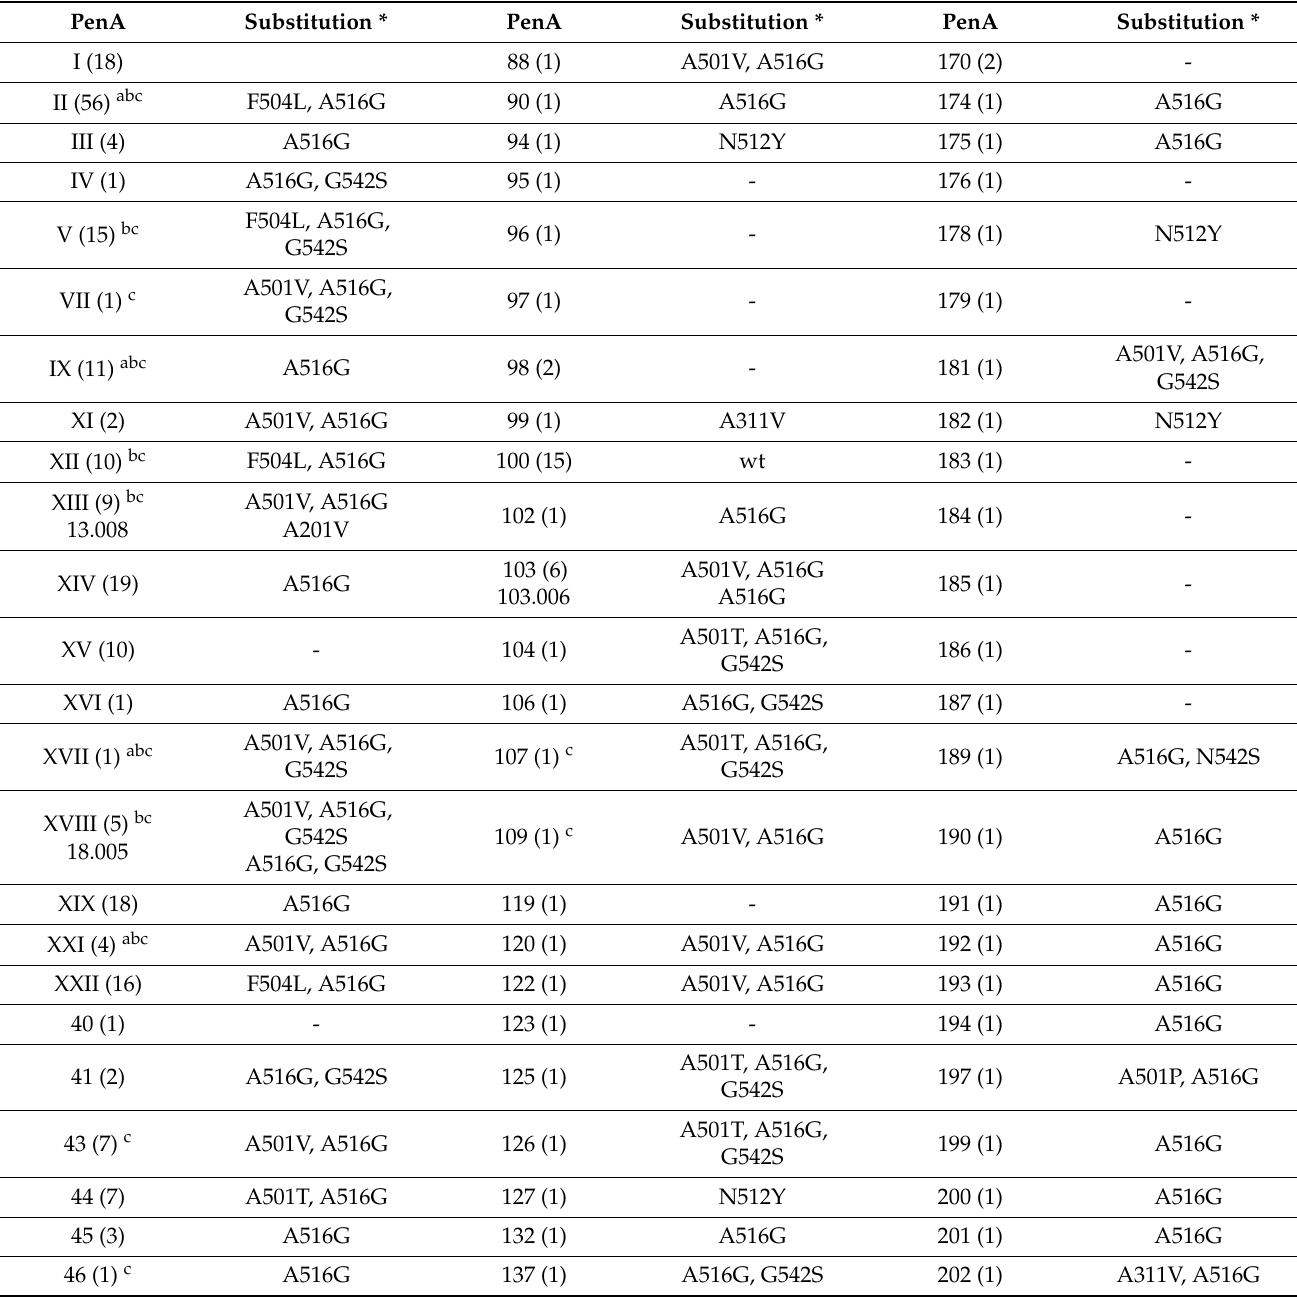
Table 3. Nonmosaic-type